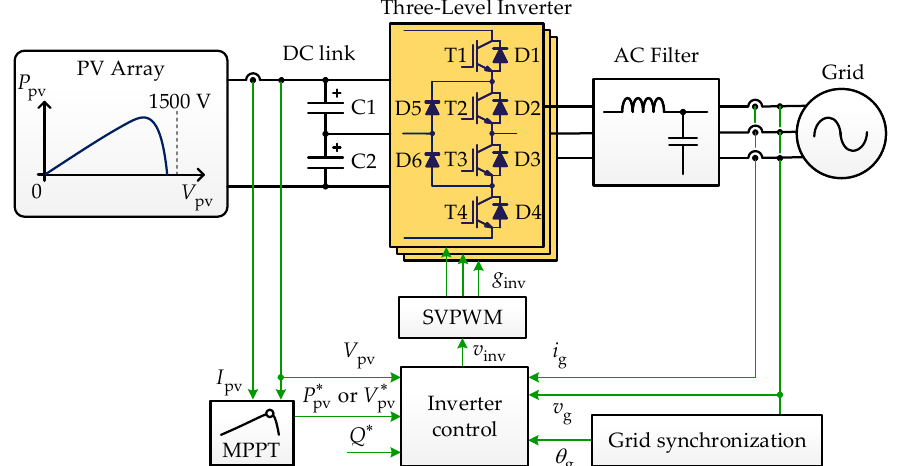
Figure 4. General configuration and control structure of the 1500 V PV system based on the three-level